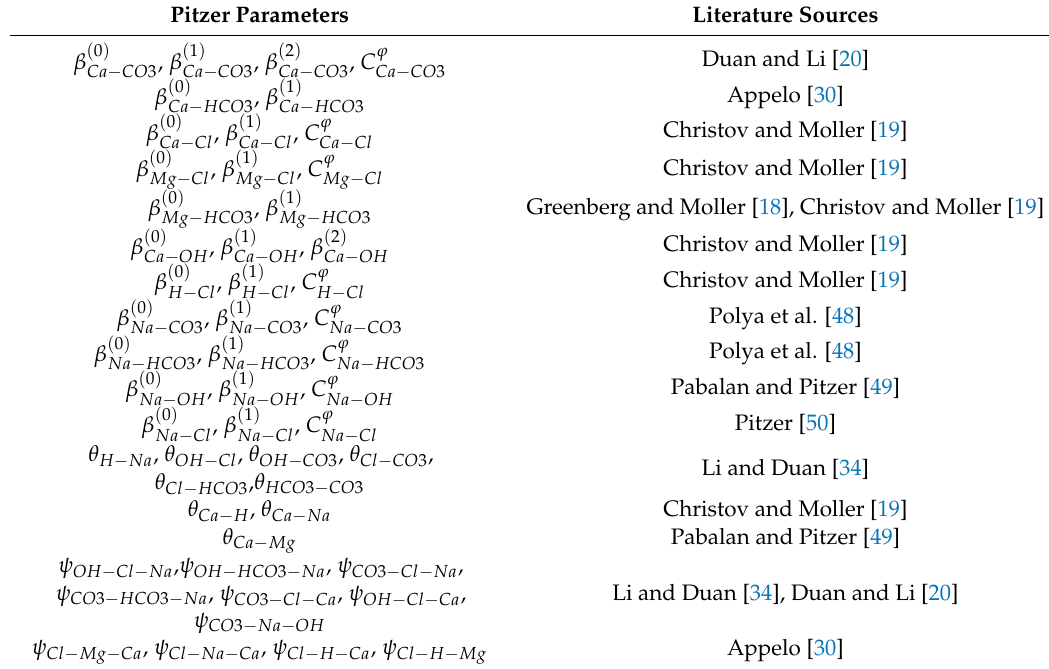
Table 5. Literature sources of Pitzer parameters.